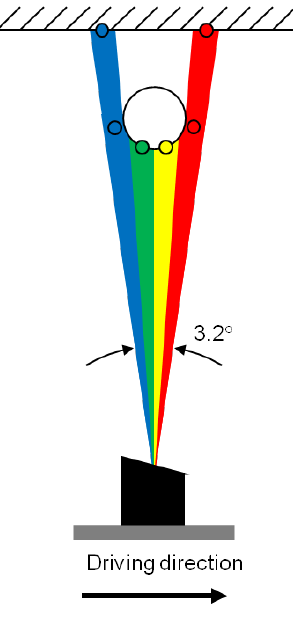
Figure 2. An indicative top-down view schematic of the measurement geometry and principle of the Ibeo Lux laser scanner (not to scale). The different colours show the different layers of the laser beam and point measured by these layers. The colours in figure are not related to hyperspectral